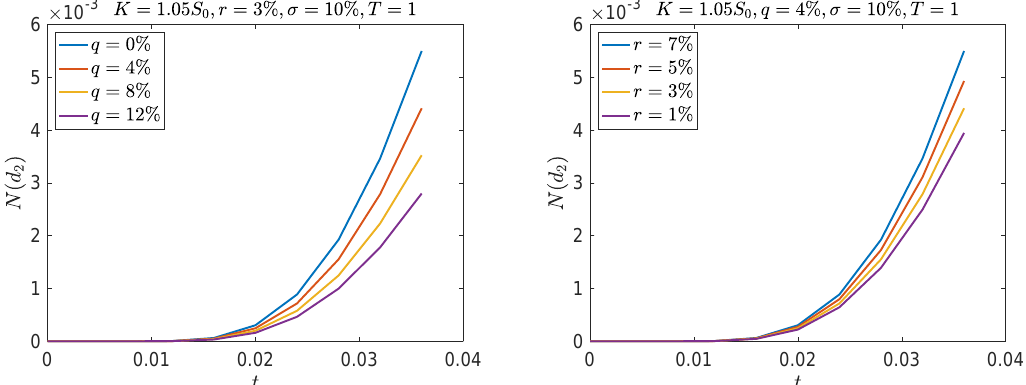
Figure 3. Probability that a call option on S is in the money at the first eight monitoring dates. Daily monitoring (250 dates for a T = 1 year